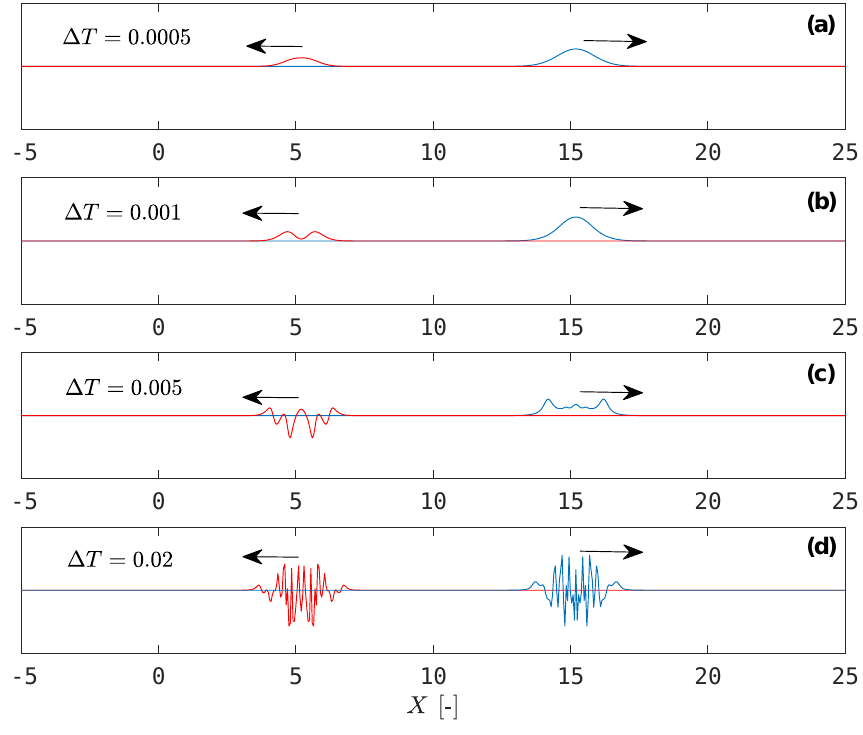
Figure 3. Comparison between the original disturbance (blue) and the time reversed wave packet (red) for different interaction times, ( a ) ∆ T = 0.0005, ( b ) ∆ T = 0.001, ( c ) ∆ T = 0.005, ( d ) ∆ T = 0.02, with n =